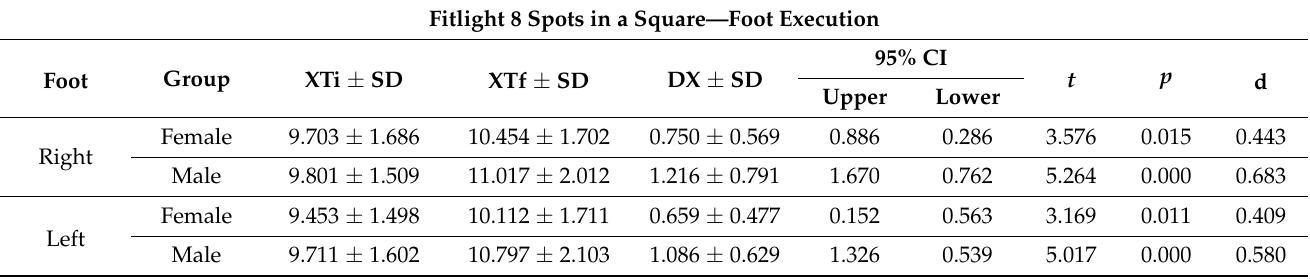
Table 4. Descriptive statistics of the Fitlight test 8 spotlights in a square—foot